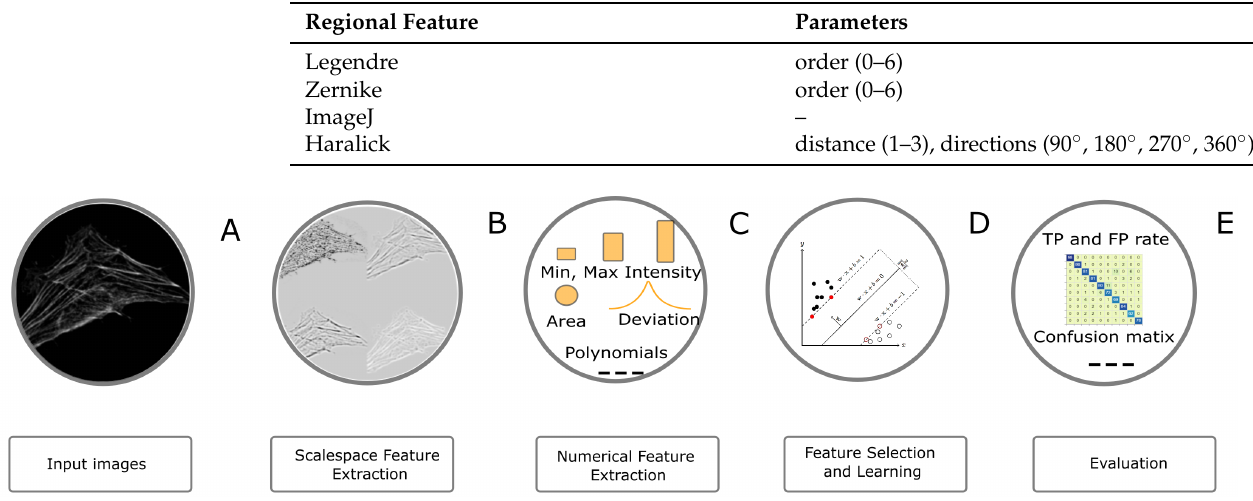
Figure 7. Overview of the Image Classification Workflow. ( A ) A sample image of filamentous actin labeled with rhodamine- phalloidin (Actin) from the HeLa data set; ( B ) Representative images of ALoG, LoG and BoG at scale 4; ( C ) Compound image transforms on original and scaled images, Feature vector is computed; ( D ) CFS based feature selection and SVM’s are used for training the model; ( E ) Several evaluation metrics are computed e.g., ROC curve, confusion matrix